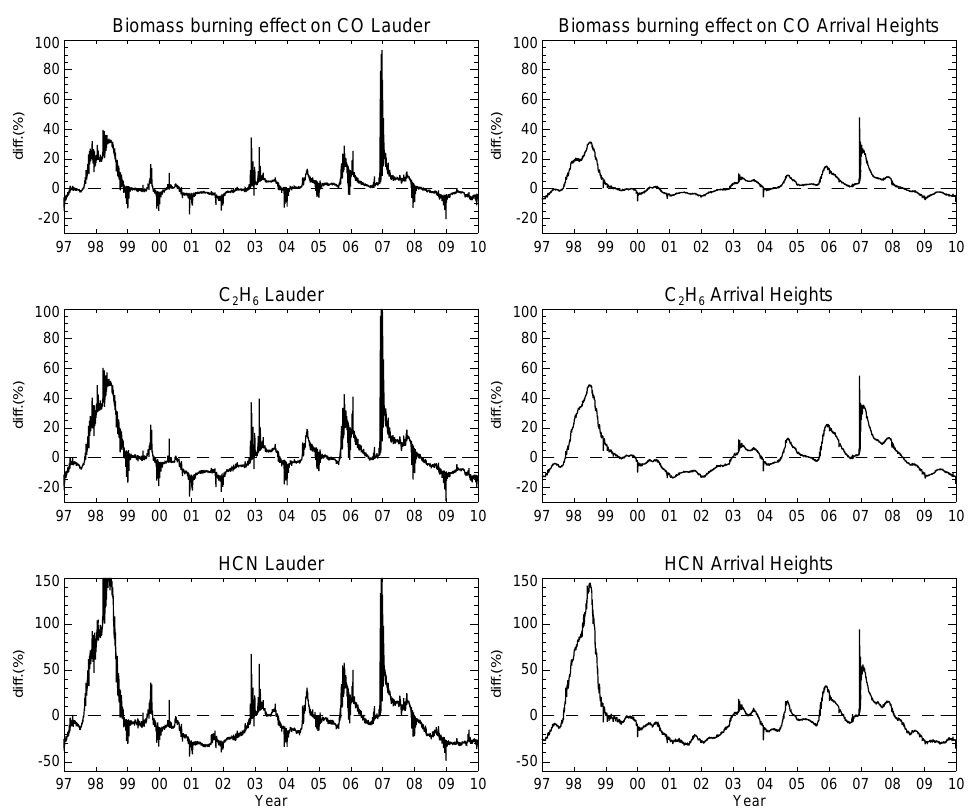
Fig. 7. Percentage differences of CO, C 2 H 6 , and HCN partial columns simulated with interannually varying biomass burning emissions, relative to a simulation with annually periodic biomass burning emissions, taken as the average over 1997–2009.